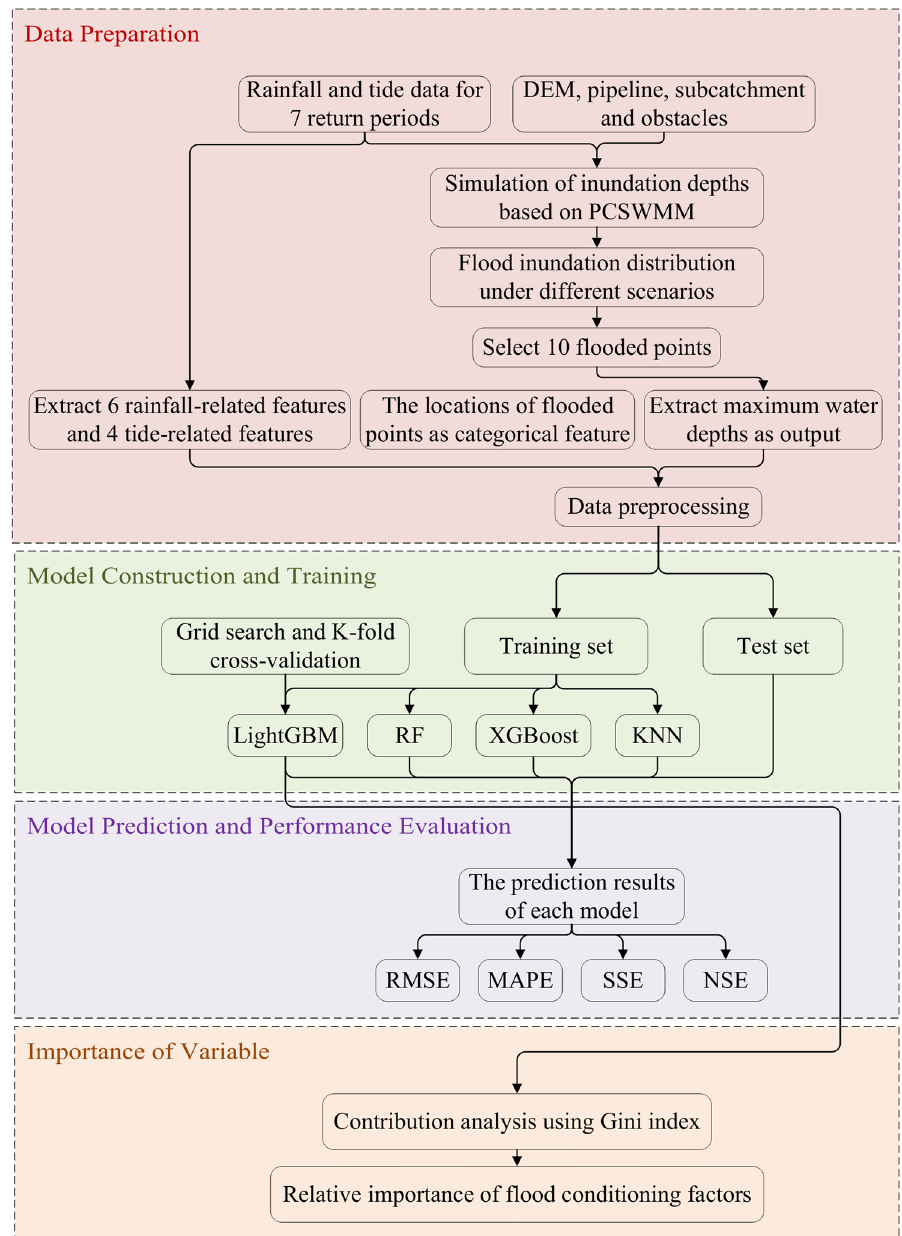
Fig. 1 Flowchart of the proposed flood prediction model. DEM Digital elevation model, PCSWMM Personal computer storm water manage- ment model, LightGBM Light gradient boosting machine, RF Random forest, XGBoost Extreme gradient boosting, KNN K-nearest neighbour, RMSE Root mean square error, MAPE Mean absolute percent- age error, SSE Sum of squared errors, NSE